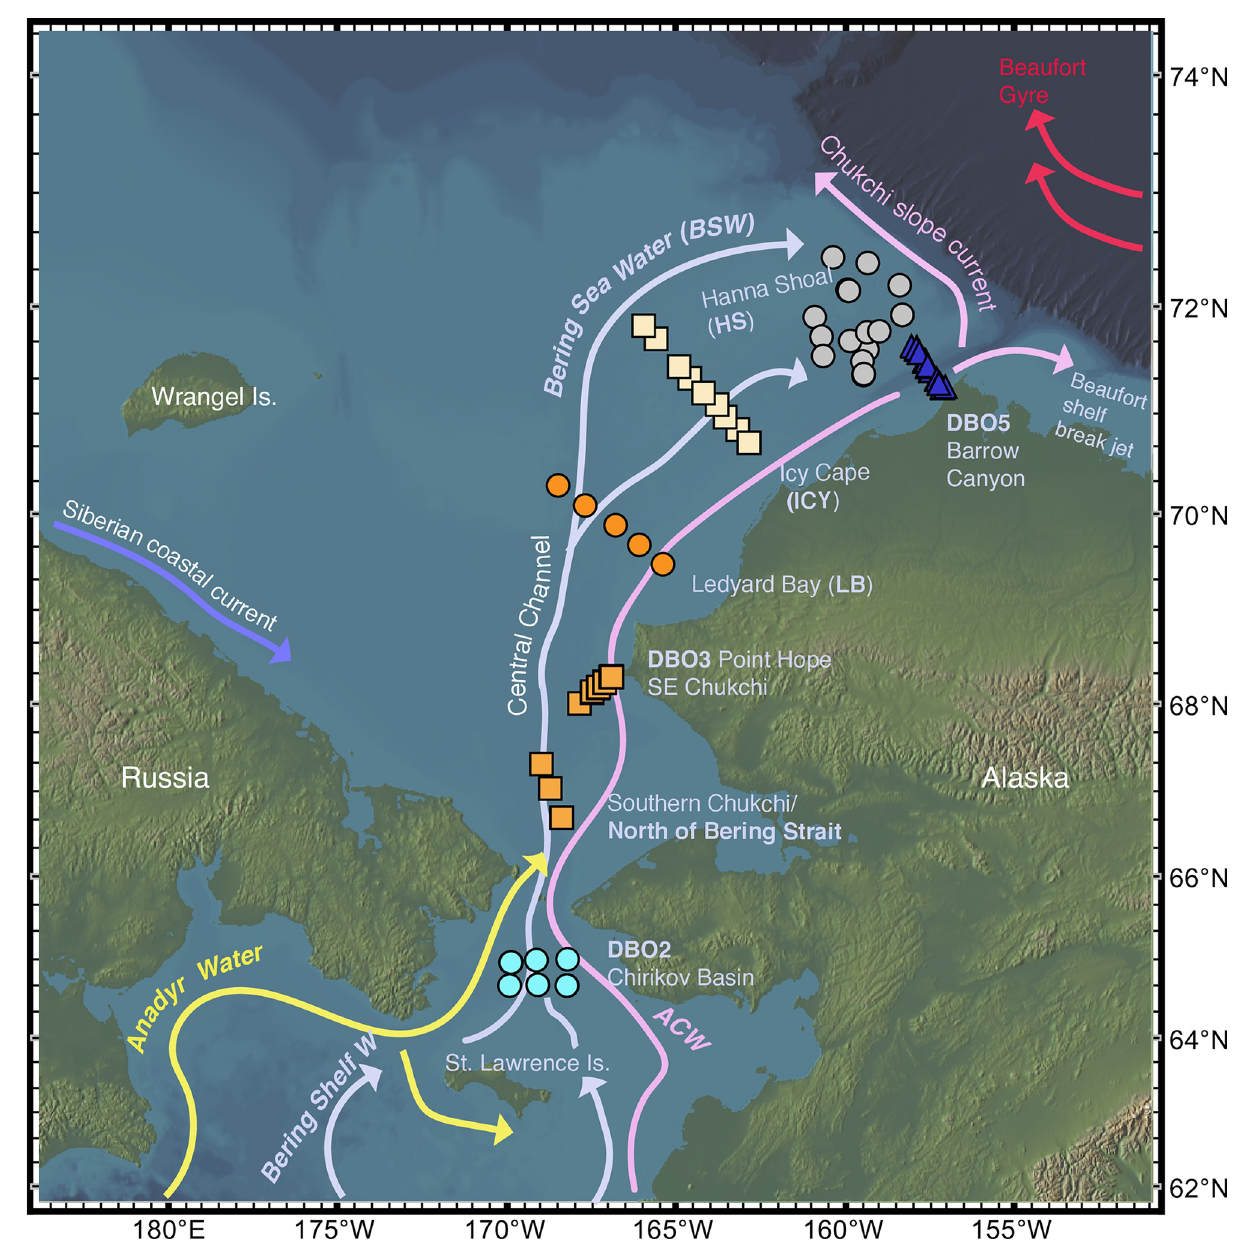
Fig 2. Location of sample sites in the northern Bering and Chukchi Seas used for ecoregion transect (nearshore to offshore) study (n = 147 surface sediment aliquots with � 30 specimens per sediment sample, 19,300 total specimens, 1990–2018). Schematic of summertime surface current flow patterns and water mass type that can affect seafloor conditions (Anadyr Water [AW], Alaska Coastal Water [ACW], Bering Sea Water [BSW]; properties denoted in Table 3) adapted from Danielson et al. (2017, 2020). Figure made with GeoMapApp [29] (www.geomapapp.org) / CC BY / CC BY